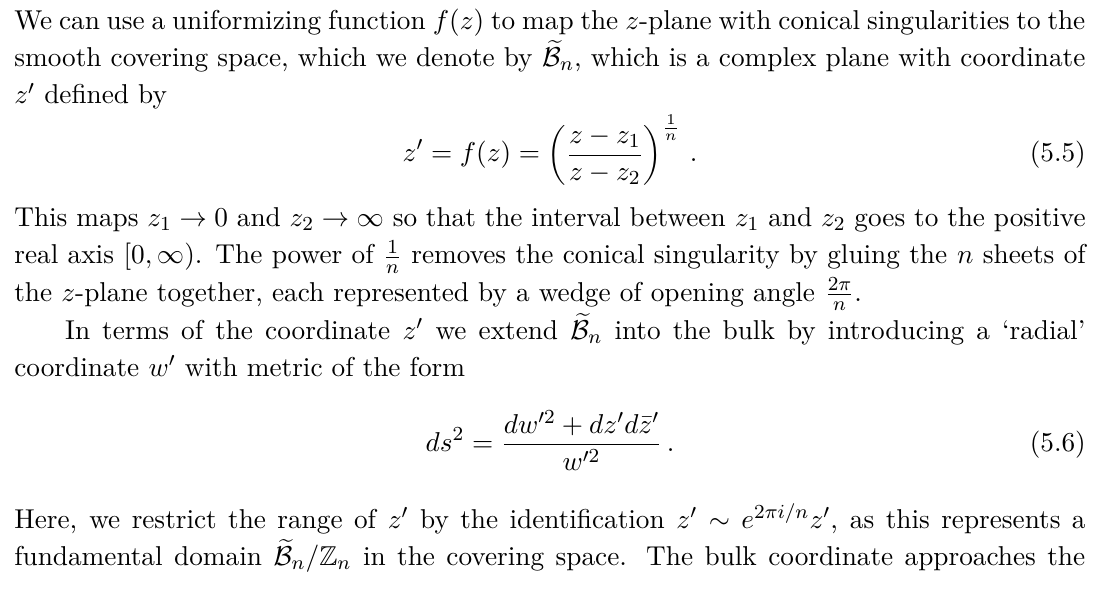
JHEP03(2022)179